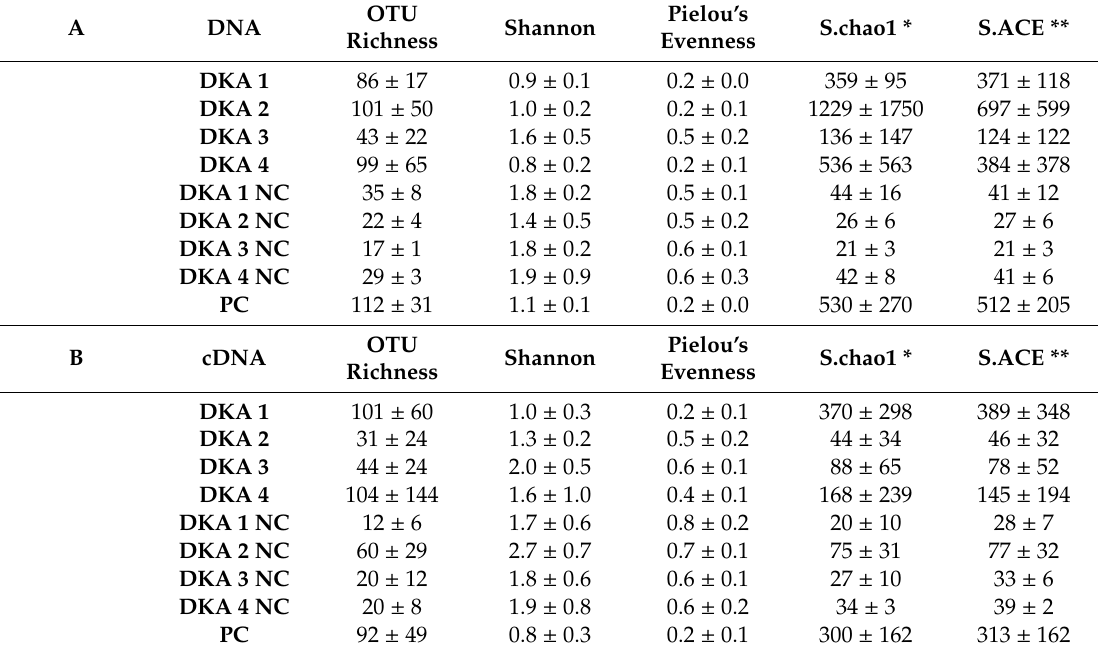
Table 3. OTU diversity indices from the tick microbiome after decontamination treatment with